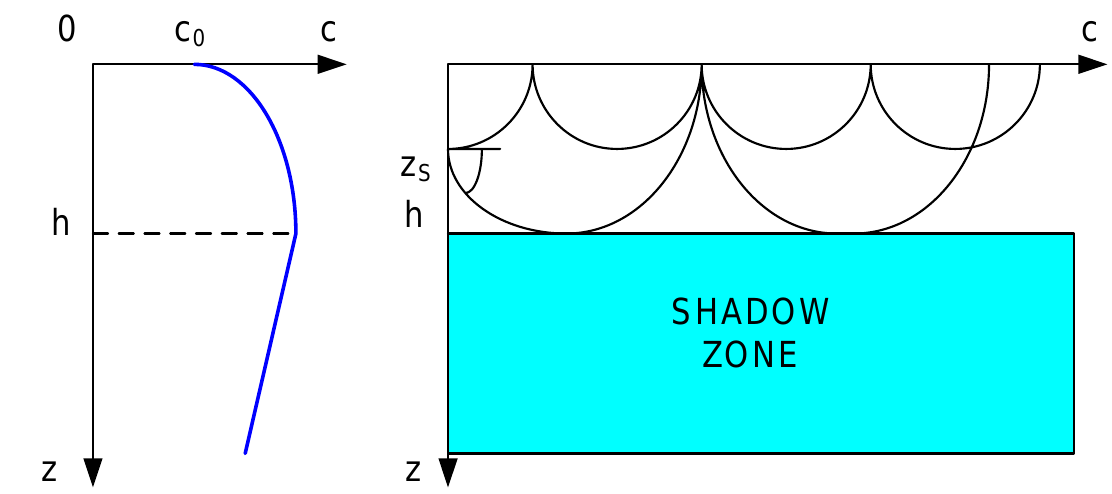
Figure 1. Shadow zone formation beneath the mixed layer when sound velocity monotically decreases with